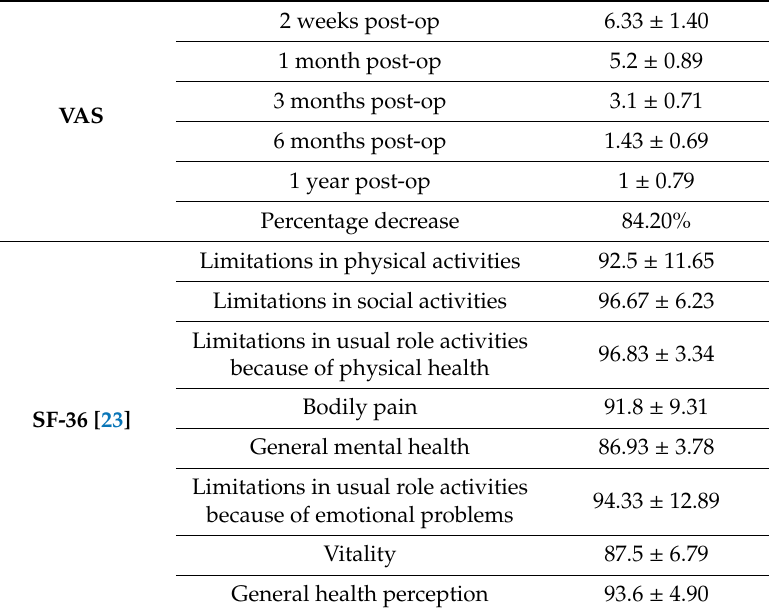
Table 2. Mean visual analogue scale (VAS) and Short Form (36) Health Survey (SF-36)